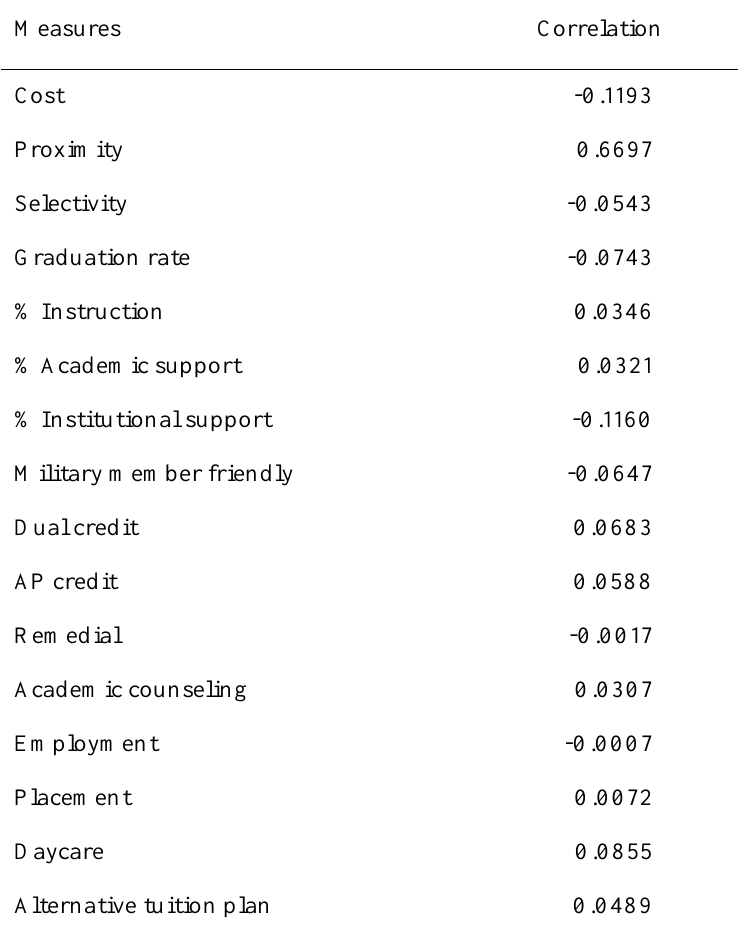
Table 2 Correlations of Dependent Variable With Other